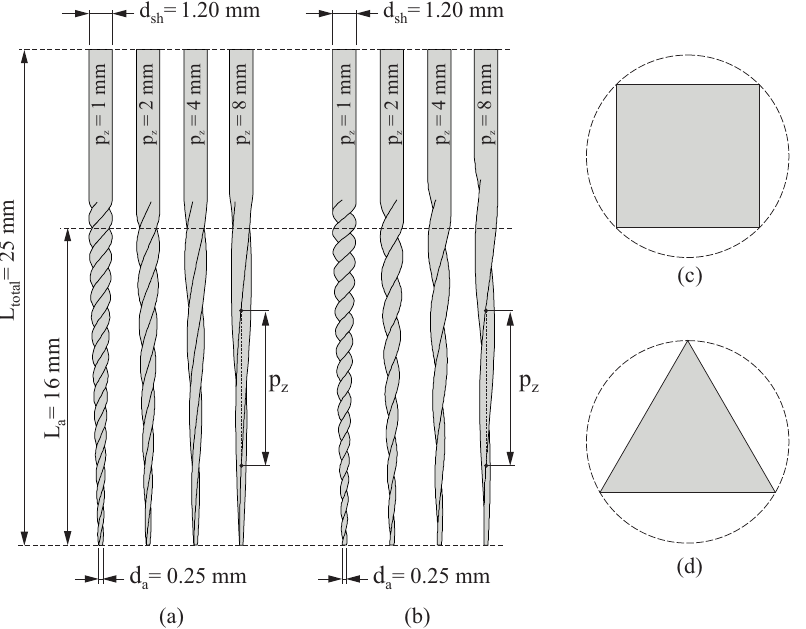
Figure 1. Geometries of the analyzed endodontic files: endodontic files with square cross-section ( a ); endodontic files with triangular cross-section ( b ); normalized square cross-section ( c ); and normalized triangular cross-section ( d ).